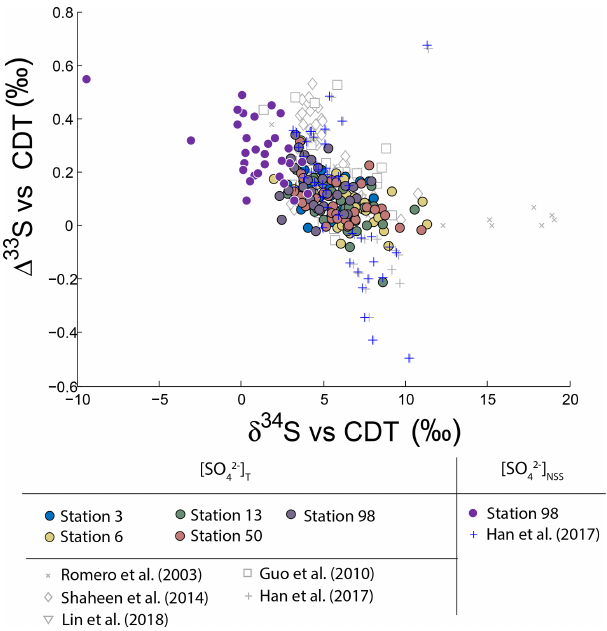
Figure 2. Variations of (cid:49) 33 S as a function of δ 34 S in sulfates from PM 10 aerosols collected in Montreal. Light grey dots are compiled from Guo et al. (2010), Romero and Thiemens (2003), Shaheen et al. (2014) and Han et al. (2017). Dark grey dots represent the NSS- s-corrected multiple sulfur isotope